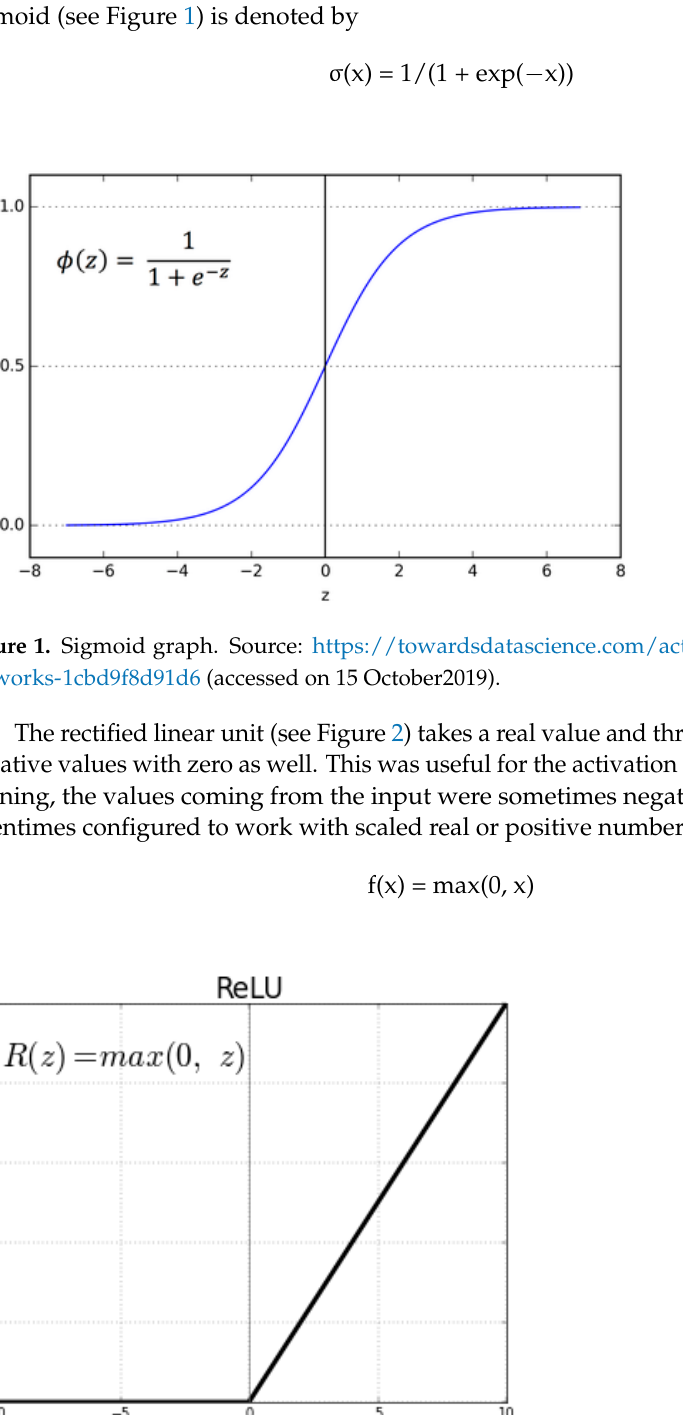
Figure 3. Tanh function. Source : https://medium.com/datadriveninvestor/neural-networks- activation-functions-e371202b56ff (accessed on 15 October 2019). The combination of the activation functions used in the hidden layers and the output layers of the DNN and the MLP is shown in Table 4.